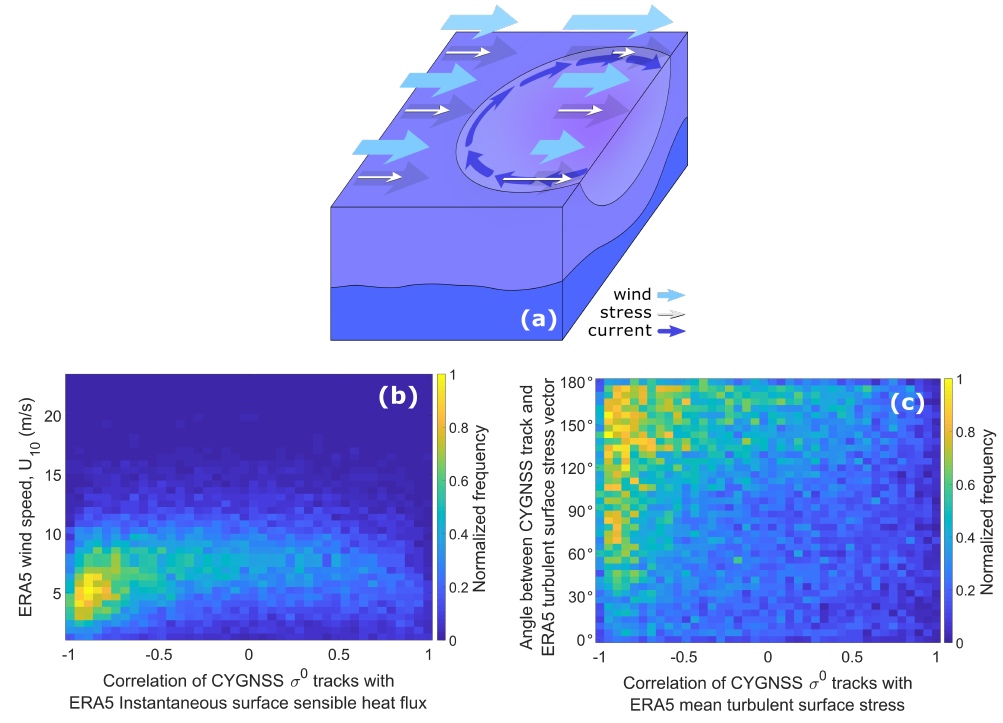
Figure 7. Schematic representation of surface stress change due to the interaction of an eastward uniform wind with the surface current associated with an anticyclonic eddy ( a ), Correlation of the σ 0 profiles of Cyclone GNSS (CYGNSS) with anomalies of instantaneous surface sensible heat flux at different wind speeds ( b ), the impact of different angular distances of the CYGNSS tracks with surface stress vector on the correlation between the σ 0 profiles and mean turbulent surface stress ( c